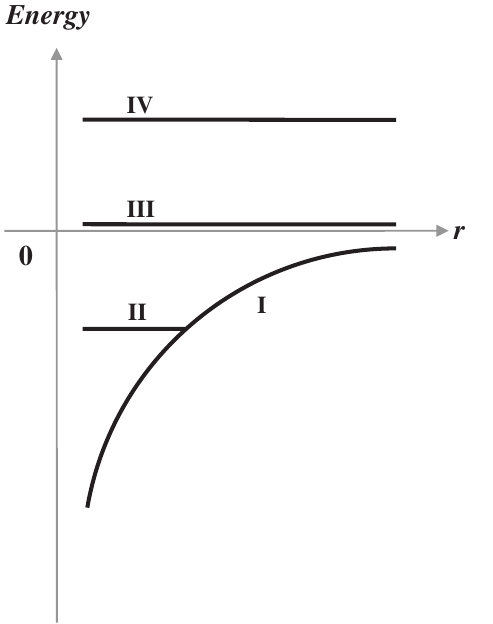
FIG. 18. Energy plot of several different states of the two- asteroid system vs the distance r between them.